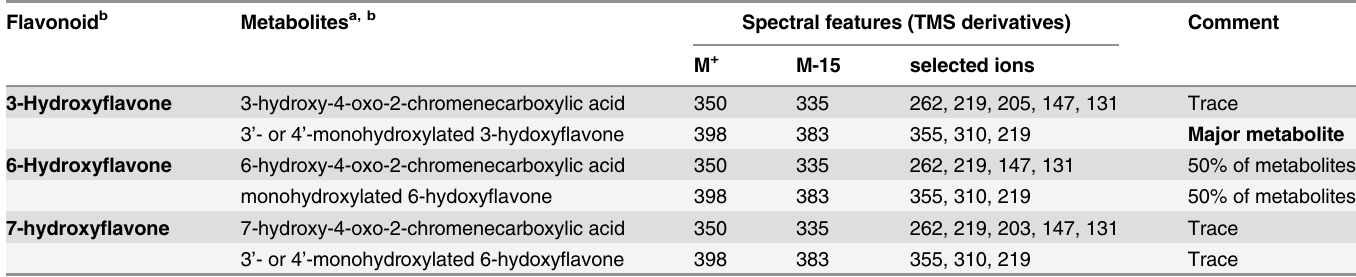
a Strain U23A was grown on sodium acetate plus anyone of the indicated fl avonoids and the metabolites were extracted and analysed by GC-MS as described in the Materials and Methods section.